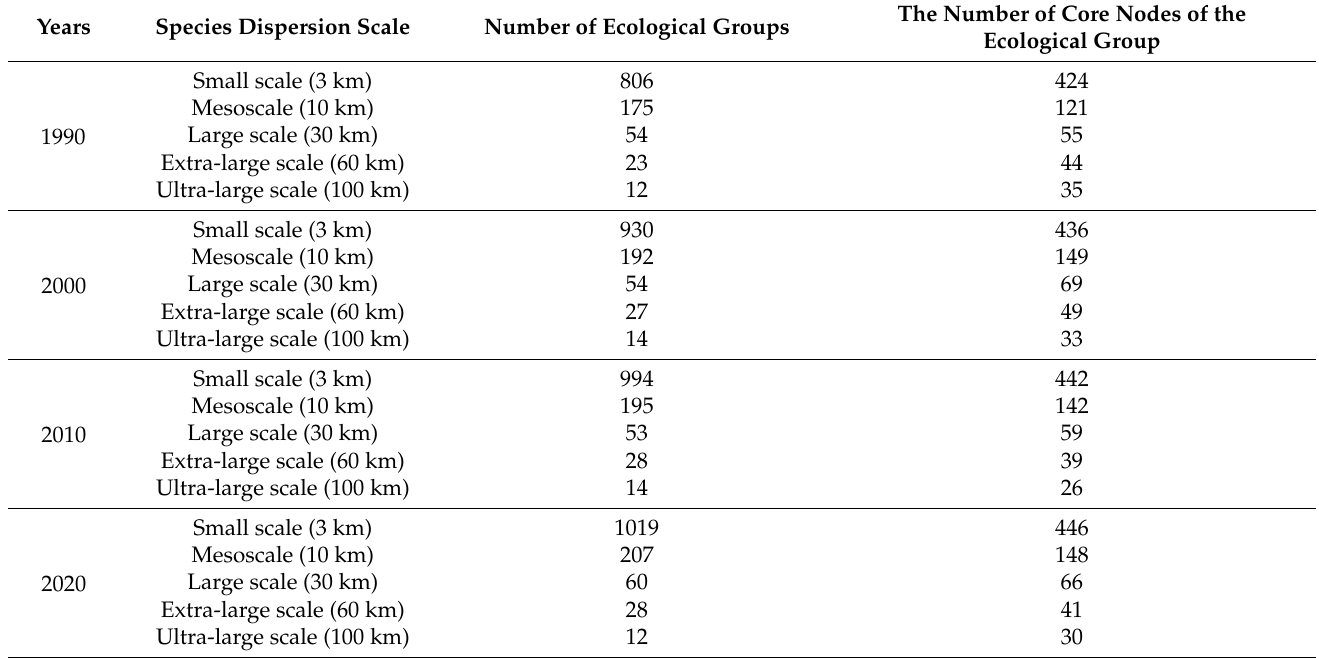
Table 6. Statistics on the characteristics of ecological groups in ecological networks. The Number of Core Nodes of the Number of Ecological Groups Ecological